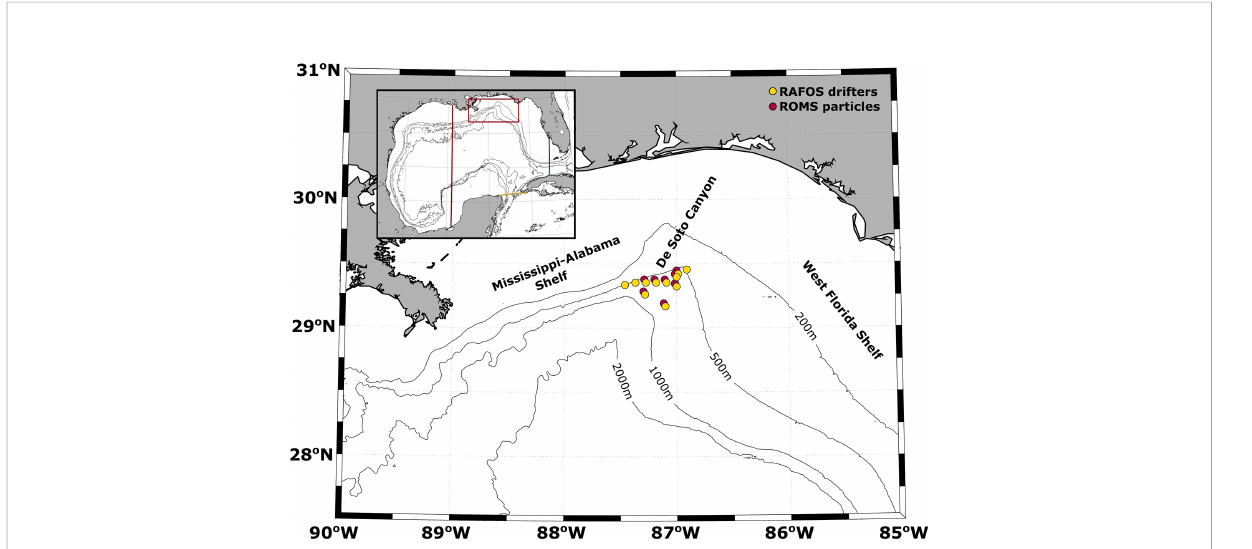
FIGURE 1 Map of the northeastern GoM with a map of the entire GoM in the top left-hand corner. The red rectangle on the full GoM map indicates the extent of the northeastern GoM (28°N – 30°N, 85°W – 90°W) as used during the SOM analysis. Red, yellow, and blue lines indicate the border between the eastern GoM and western GoM, Caribbean, and Atlantic, respectively, for the particle ending location calculation in Section 3.4 and Figure 12. Isobaths are shown in black at 200, 500, 1,000, and 2,000 m. Yellow and red circles indicate RAFOS drifter and ROMS virtual particle deployment locations,